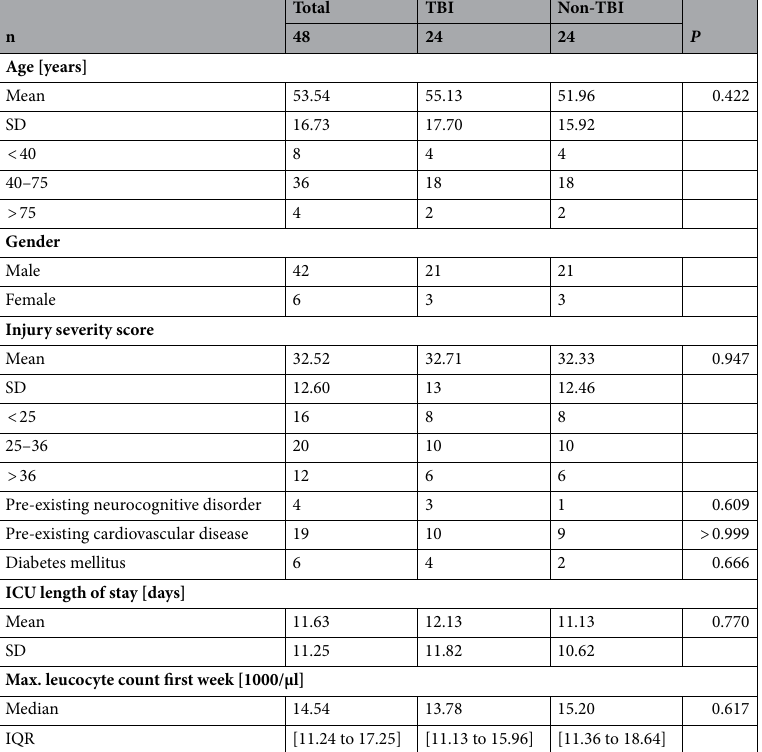
Table 1. Patient characteristics. Presented in total and within matched groups. P -values of between-group comparisons of patients with traumatic brain injury (TBI) and without (non-TBI) calculated by Mann Whitney or Fisher’s exact test. All P > 0.05. SD standard deviation, IQR inter-quartile ratio, ICU intensive care unit.